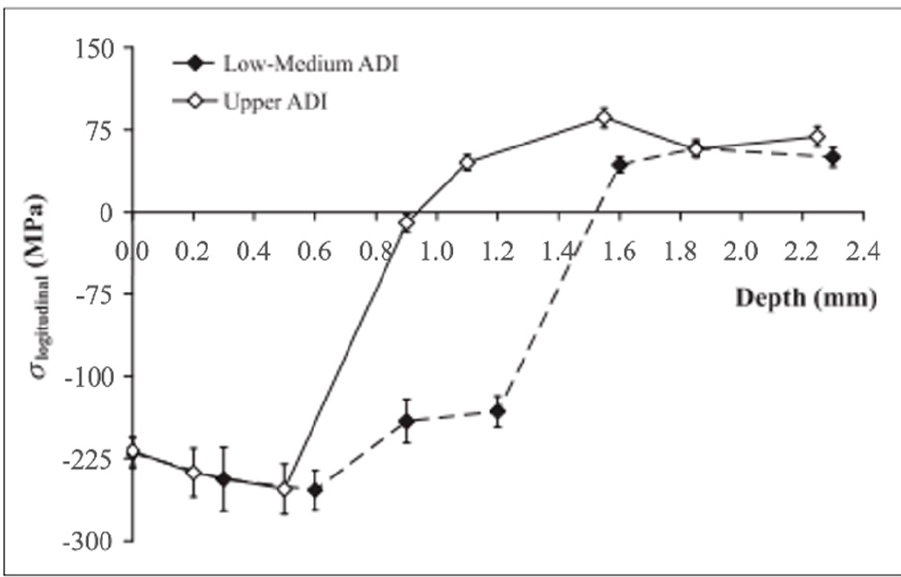
Figure 11. Evolution of residual stresses in the center of the laser track as a function of depth and ADI sample ((Reprinted with permission from ref. [60]. 2011 Elsevier).